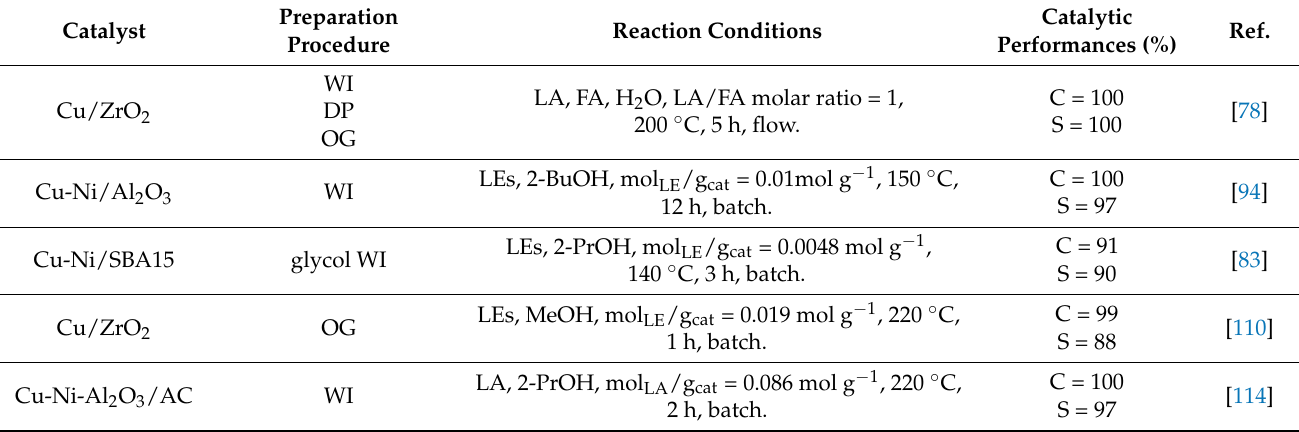
Table 2. Catalysts for the CTH of LA/LEs to